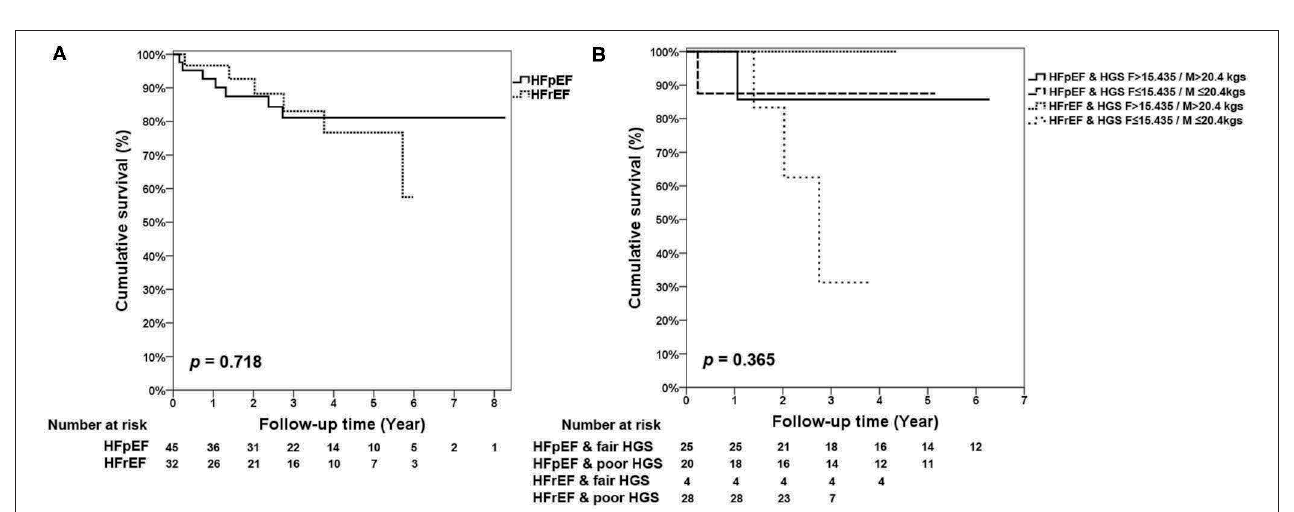
FIGURE 2 | KM survival curves for (A) HFpEF and HFrEF. (B) Mortality stratified by the different levels of HGS, HFpEF, and HFrEF.